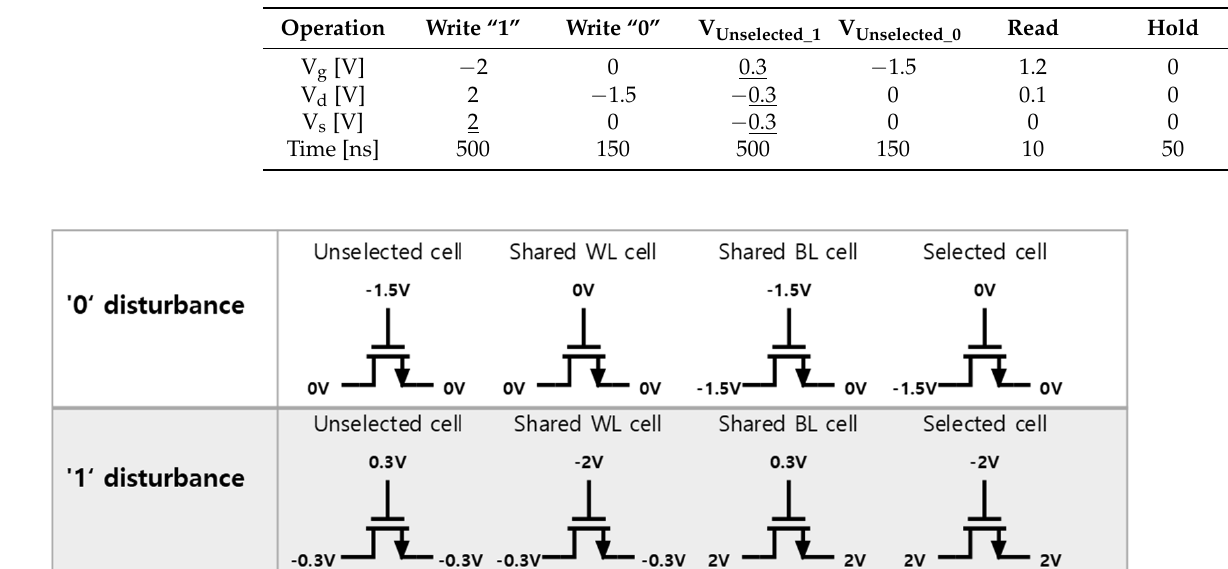
Figure 9. Timing diagram of second simulation for ( a ) the selected WL, BL, and SL and ( b ) unselected WL, BL, and SL. Table 4. Bias and time conditions for transient operation in second simulation.